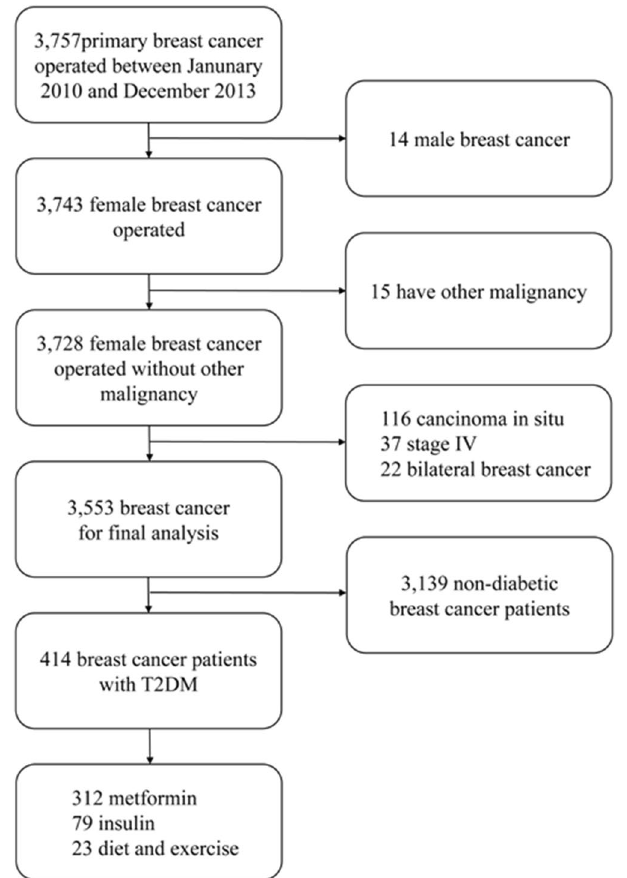
Figure 2. Flow chart of patient selection for final